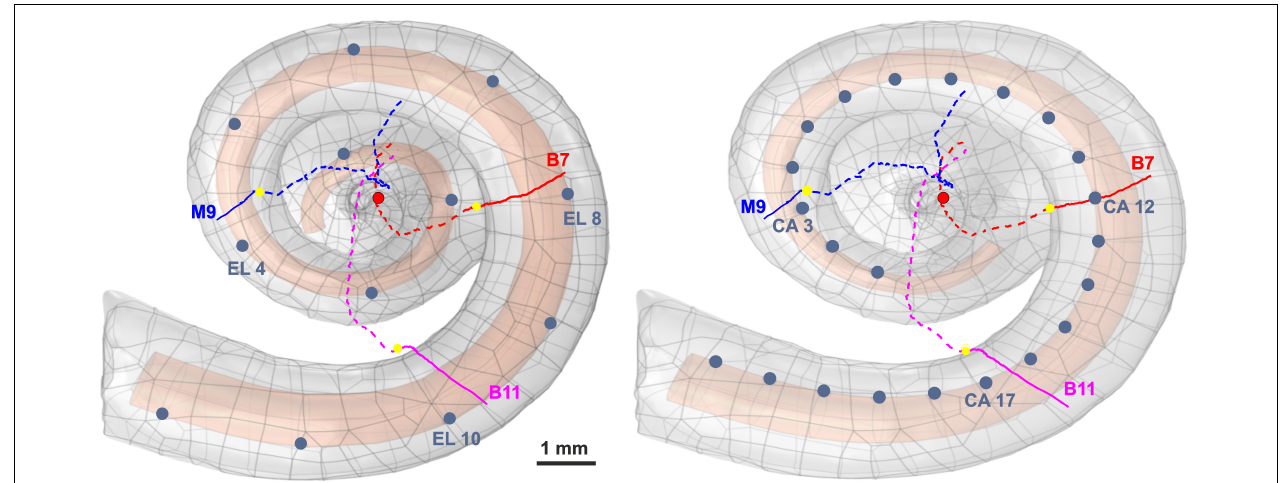
FIGURE 1 | Three-dimensional model of scala tympani including 12 electrodes of a lateral CI (left) and 22 electrodes of a perimodiolar CI (electrodes are close to the center, right), as well as the three investigated pathways of ANFs. The peripheral part, soma position, and central part of the nerve pathways are represented with colored solid lines, yellow spheres, and colored dashed lines, respectively. For the sake of clarity, all electrode positions are shown as dark blue spheres, although in calculations each active electrode is a hemisphere. The axis of modiolus is marked as red circle.